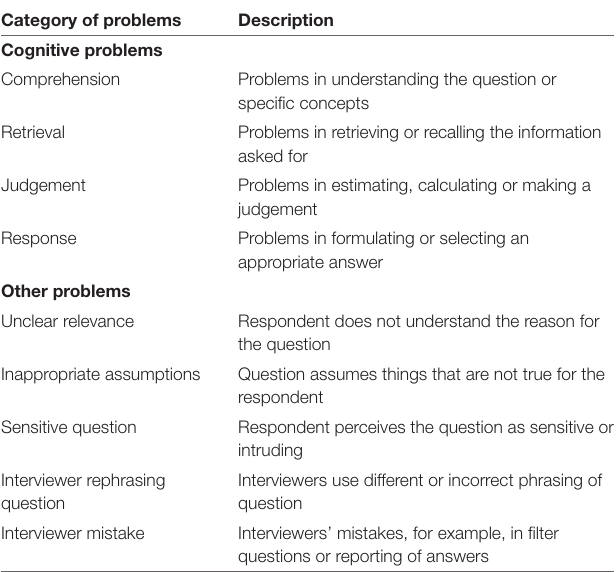
TABLE 1 | Categories of problems with the questions and